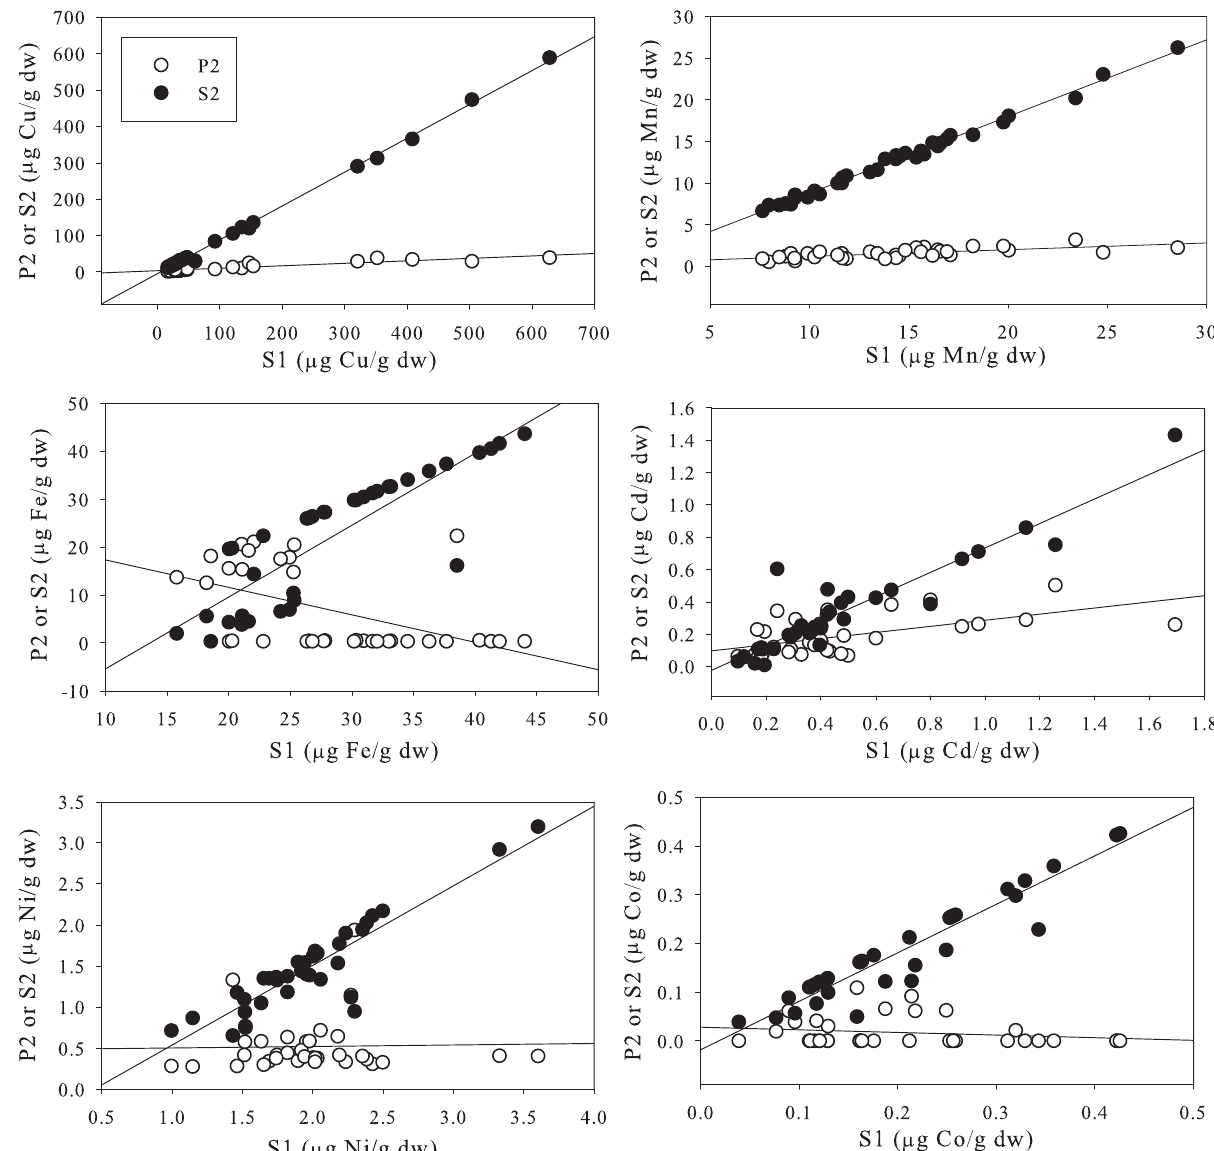
Fig. 7. Relationship between metal content in P2 and S2 fractions and total metal in cytosol of gill. Data for Zn not are available. For each metal values relative to both stations are considered together. Metal concentrations are expressed in µg/g dry